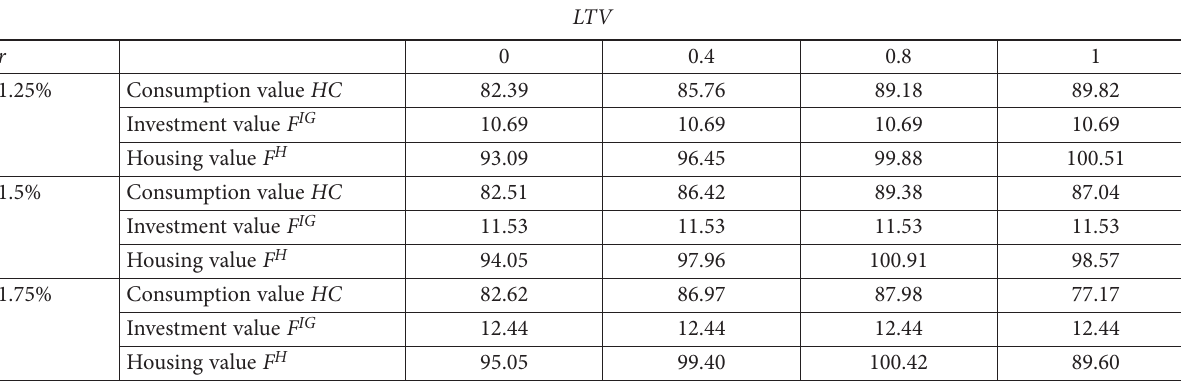
Table 3. Consumption, investment, and housing values across LTV ratio and interest rate *